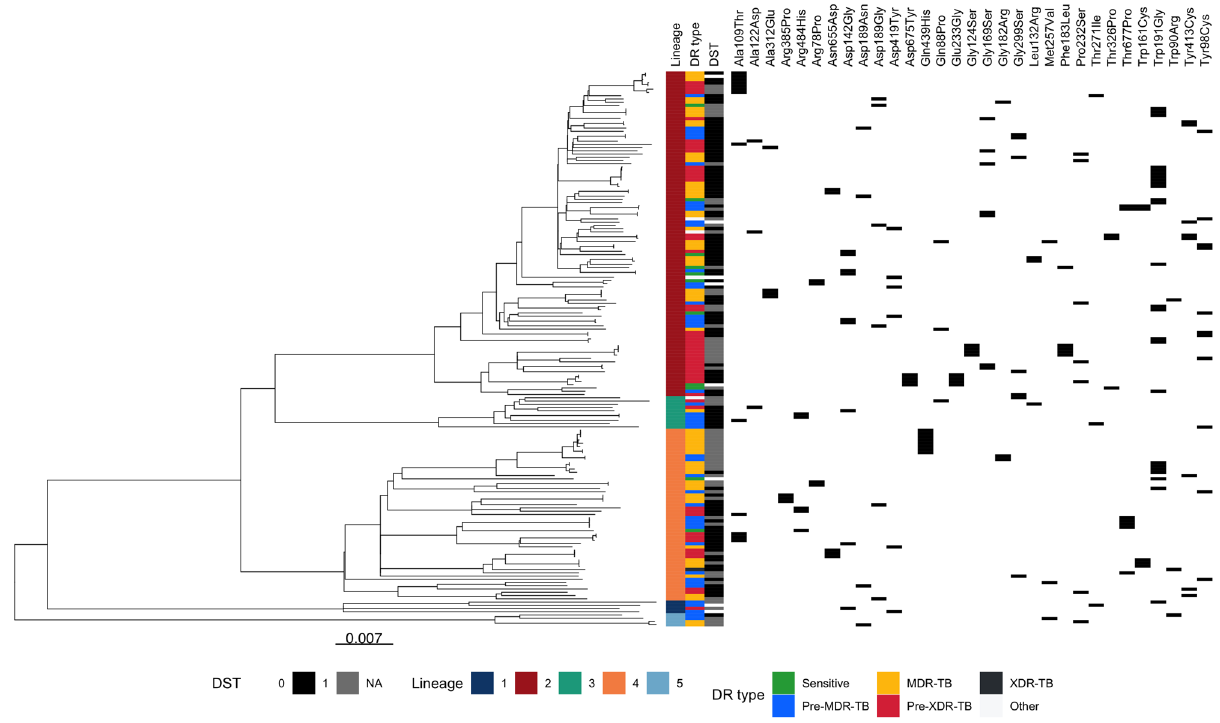
Figure 1. Phylogenetic tree of isolates (n = 171) with 31 putative novel katG gene mutations for Isoniazid resistance, with lineage, drug resistance (DR) status, and phenotypic drug susceptibility test (DST) data.